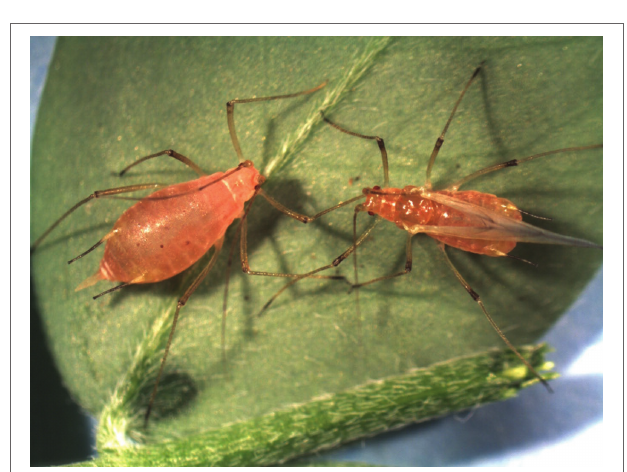
FIGURE 2 | Wing polyphenism in aphids. Winged (right) and wingless (left) forms of female aphids, Acyrthosiphon pisum (Reproduced with permission from Simpson et al.,